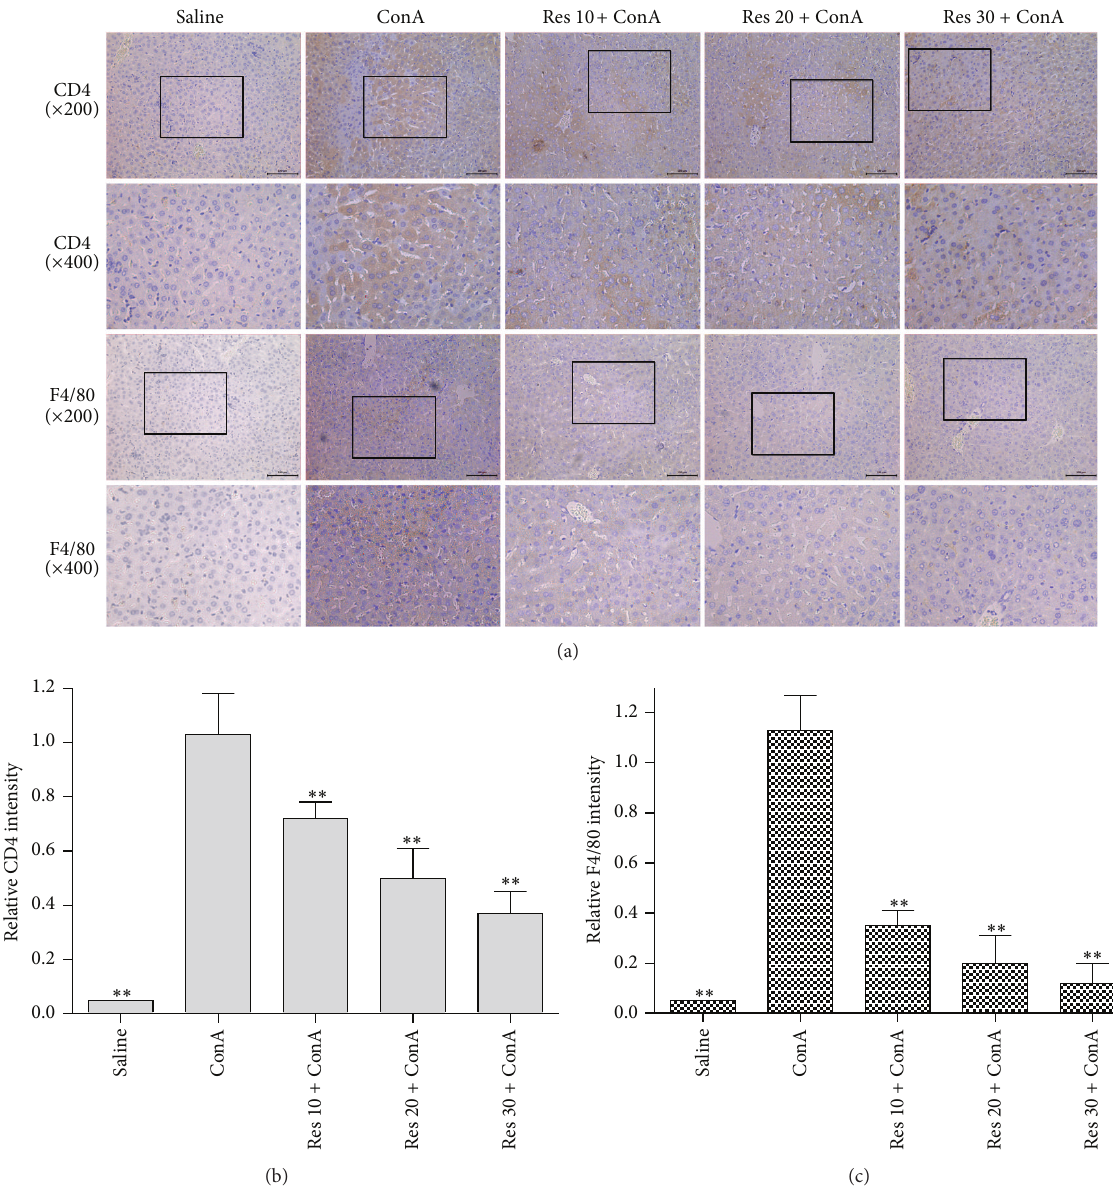
Figure 4: Immunohistochemistry used to detect the expression level of CD4 and F4/80 8 hours in all five groups (saline group, ConA model group; ConA + 10mg/kg Res; ConA + 20 mg/kg Res; ConA + 30 mg/kg Res). CD4 and F4/80 showed strong immunoreactivity in ConA sections, but it was weak after Res application in different dose